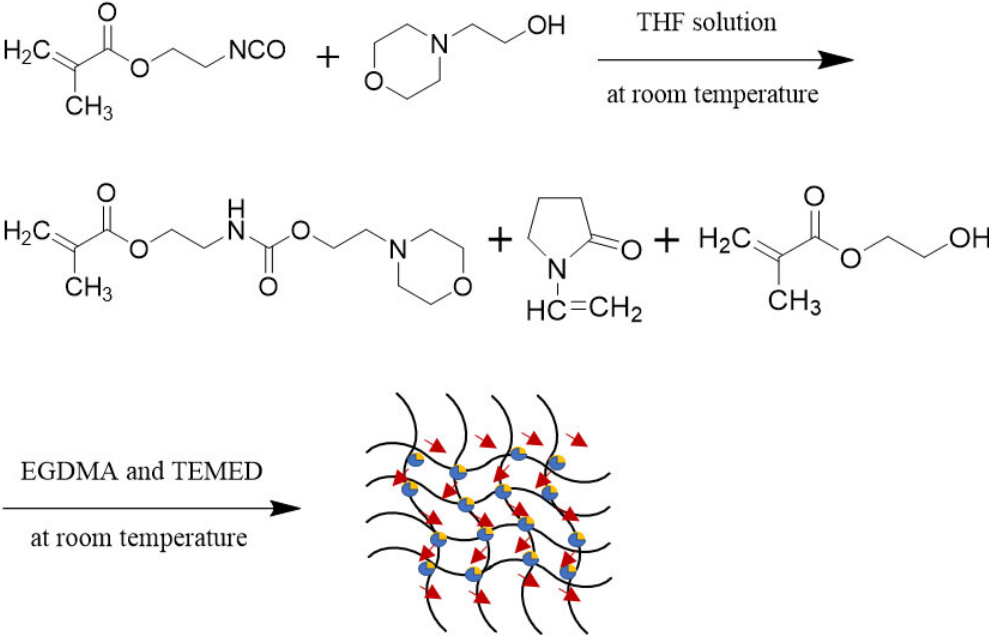
Scheme 1. Schematic diagram of the synthesis of copolymer hydrogels.